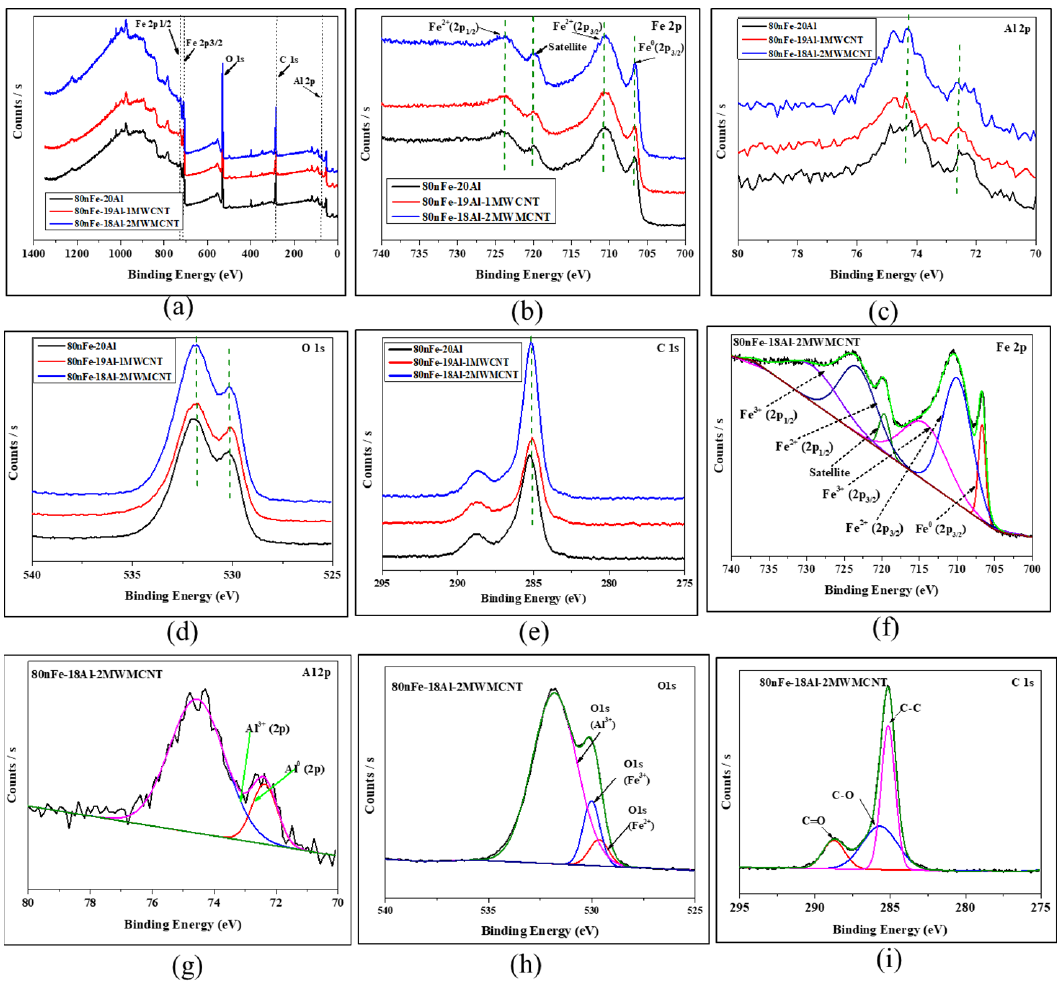
Figure 5. XPS analysis: ( a ) survey; ( b ) Fe 2p; ( c ) Al 2p; ( d ) O 1s; ( e ) C 1s; ( f – i ) deconvolution of Fe 2p, Al 2p, O 1s and C 1s for 80nFe-18Al-2MWCNT respectively.